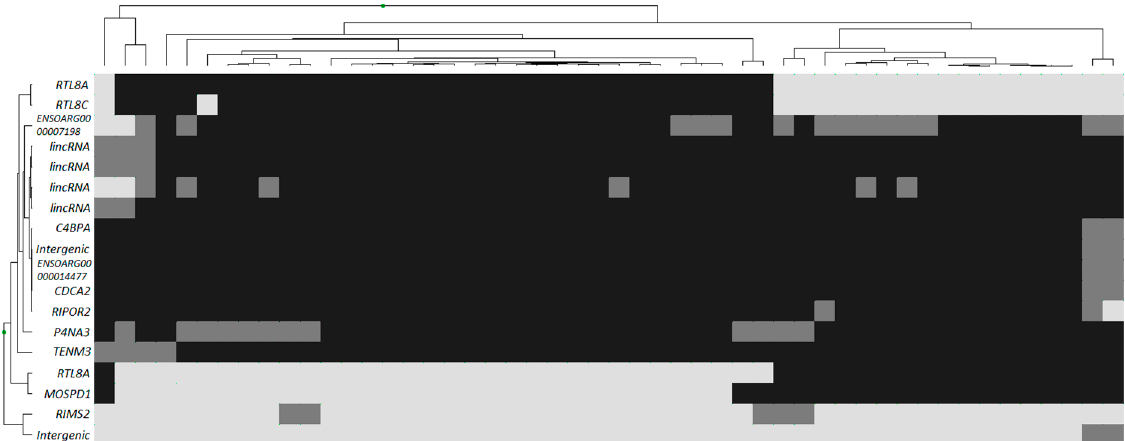
Figure 5. Heatmap of genotypes associated with meat production trait gene polymorphisms in Jalgin merino. Clustered individual genotypes. Light grey: wild homozygote; grey: heterozygote; dark grey: mutant homozygote.